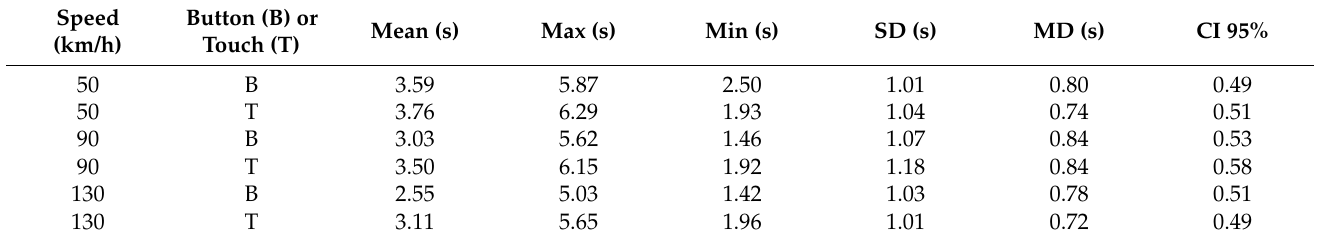
Table 2. TEORT and statistical values.